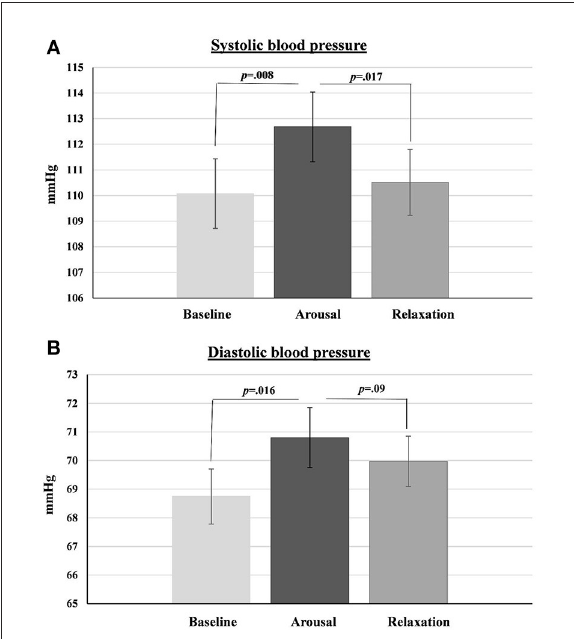
FIGURE2 Systolic (A) and diastolic (B) blood pressure at baseline, arousal phase and relaxation phase. Error bars represent SEM.